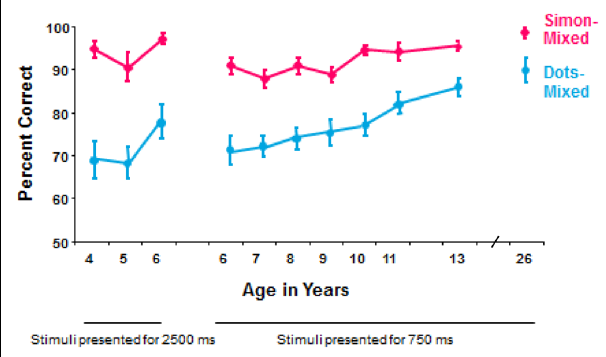
FIGURE 1 | Comparison of performance on the mixed conditions of the hearts and flowers task with dot stimuli and of a Simon task. This is based on within-subject comparisons of 314 participants (roughly 30 per age; equal numbers of males and females) tested on both tasks using the same equipment and same timing parameters (Davidson etal., 2006). At every age, participants were significantly faster and significantly more accurate on the Simon task.The dot stimuli were a gray disk and a black- and-white-striped disk; that is the only difference between the older dots version of the task and the current hearts and flowers task.The rules for the Simon task were, “If you see a butterfly, press the button on the left, whether the butterfly appears on the left or right. If you see a frog, press the button on to the right, whether the frog appears on the left or